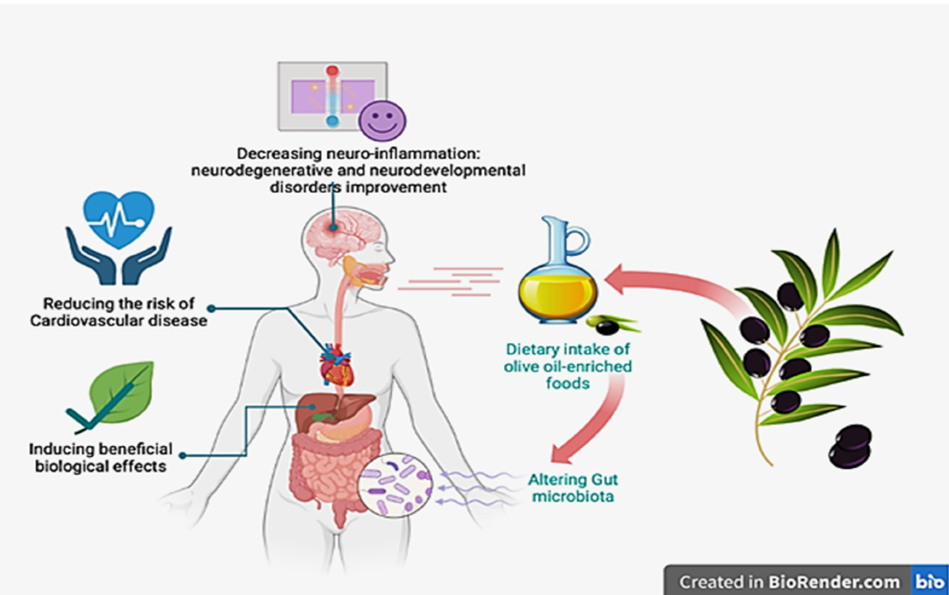
Figure 1. Illustration adapted with permission from Ref [81], 2019 Gavahian M. et al., under